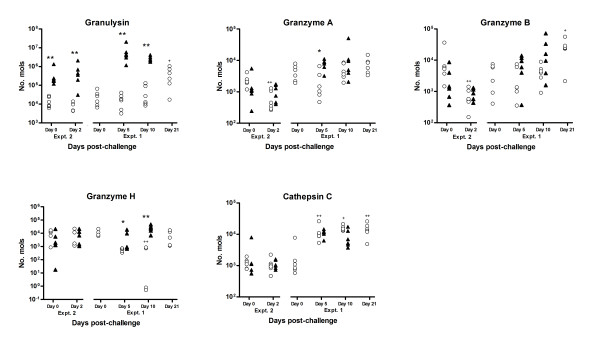
Results of competitive multiplex qRT-PCR analysis to investigate temporal changes in the expression levels of transcripts normally associated with cells exhibiting cytotoxicity; granulysin, granzymes A, B and H, and cathepsin C, as indicated, throughout the experiment trials summarised in Table 1. Open circles represent data from naïve sheep; closed triangles represent data from immune ("previously infected") sheep. Significant difference between Nv and Im at same timepoint; *P ≤ 0.05, **P ≤ 0.005, ***P ≤ 0.005; Significant difference between timepoint and day 0 of same group (where available); +P ≤ 0.05, ++P ≤ 0.005, +++P ≤ 0.005 (Mann-Whitney U-test for non-parametric data). NB.- data for granzyme H- model fitting failed in some samples, so n = 5 in some groups as indicated.